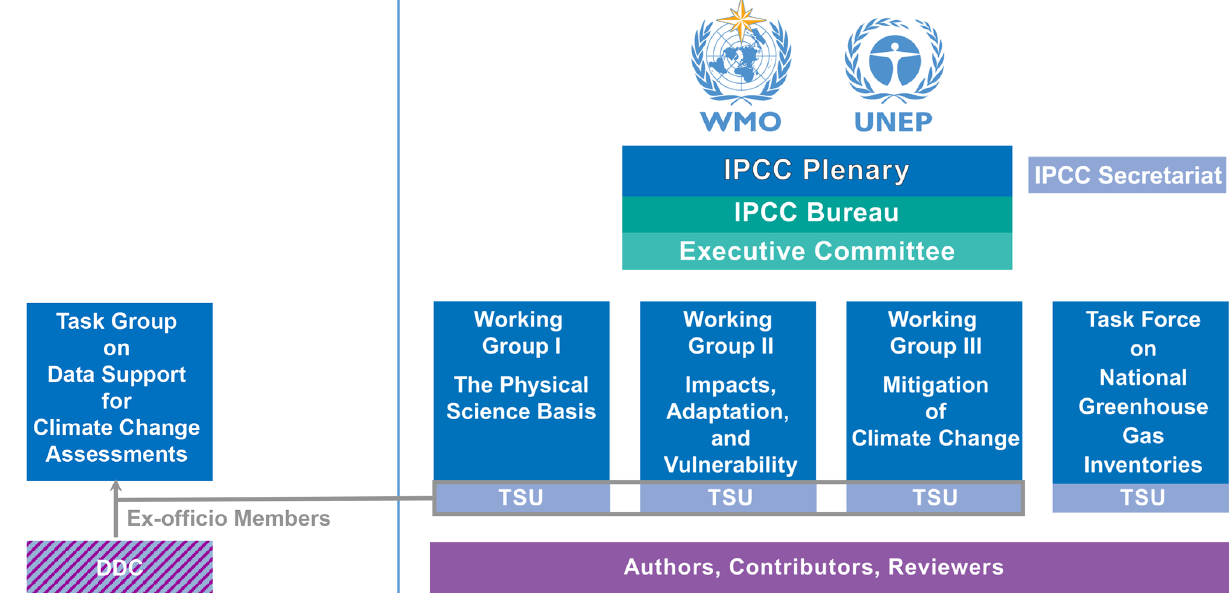
Figure 1. IPCC structure (from IPCC web